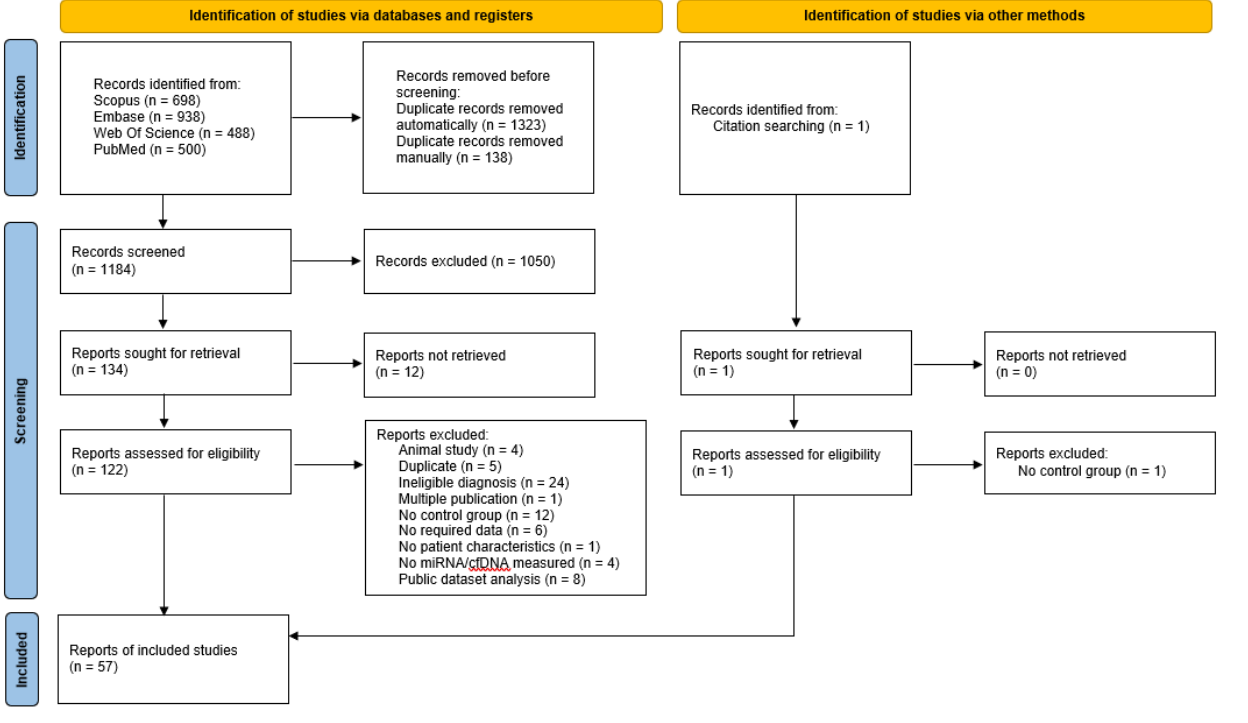
Figure 2. PRISMA flowchart of studies screened and included in this review (http://www.prisma- statement.org/; Accessed on 5 September 2022).